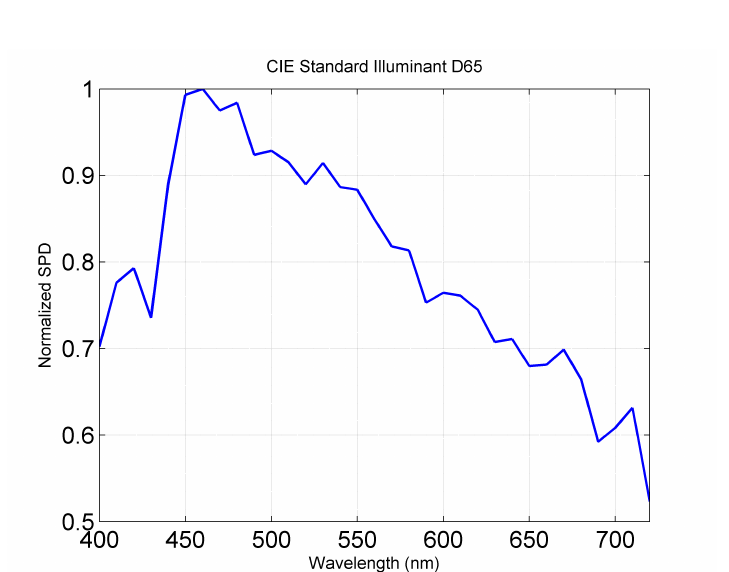
Figure 2. The D65